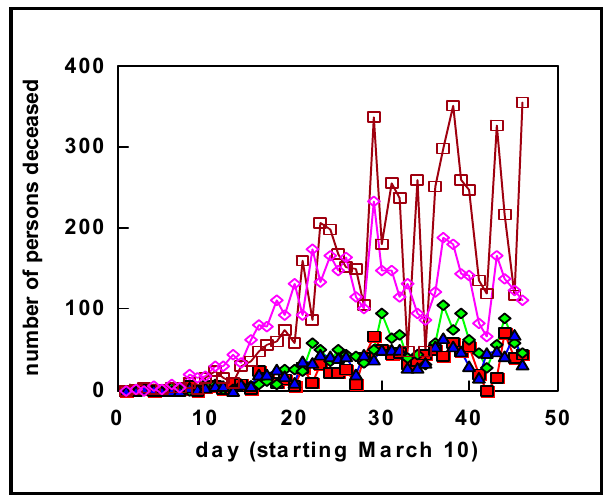
Figure 5. Daily increments of deaths (ordinate) during the period 10 March–24 April 2020 in three German Bundesländer—North-Rhine-Westphalia (red squares), Bavaria (green diamonds), and Baden-W ű rttemberg (blue triangles)—with Germany (brown open squares) and the Netherlands (pink diamonds). The larger fluctuations seen, in particular, for the data on Germany and the Netherlands were also comparatively larger in the early days but less visible in this graph because of the lower numbers (ordinate). The fluctuations might be real differences between subsequent days, but they are more likely the result of the time when data are officially reported. Independent of the cause, overall it does not influence the overall trends over time as discussed in this paper.